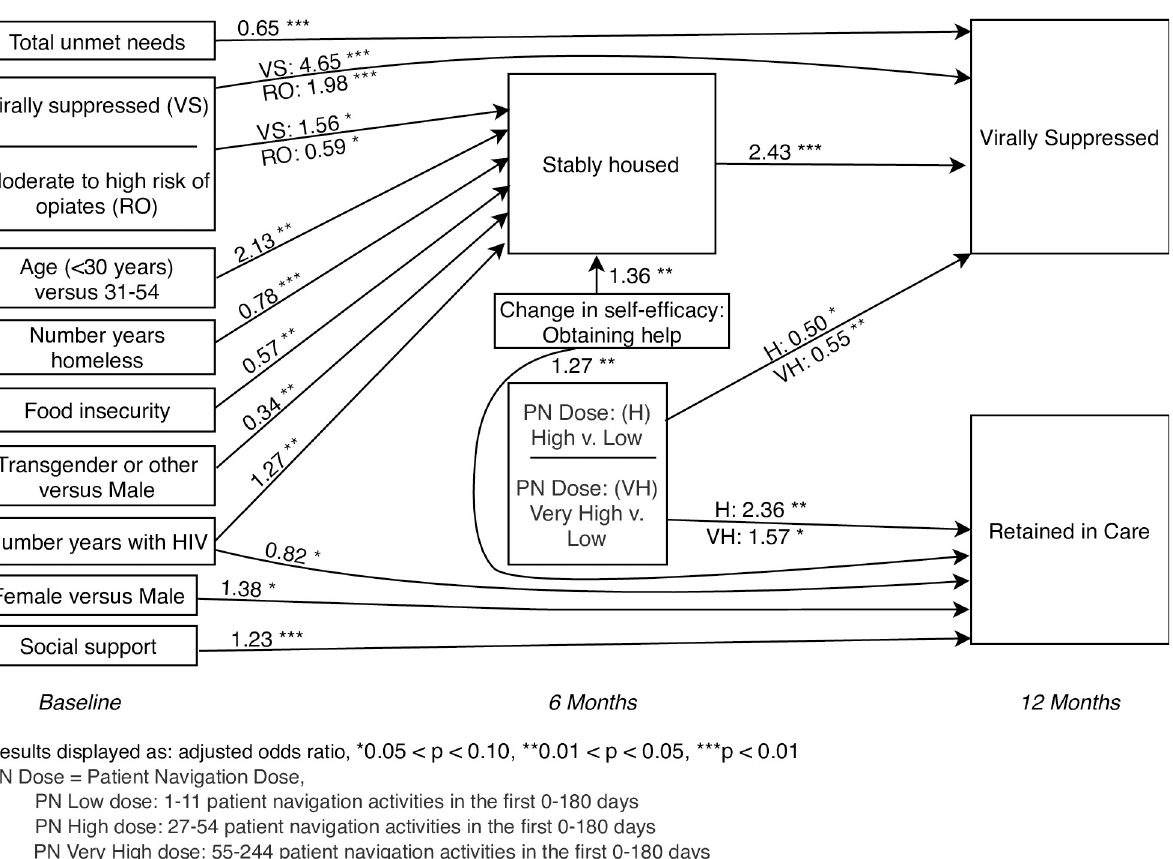
Fig 2. Path model for participant characteristics and navigation activity level on housing stability and HIV health outcomes.